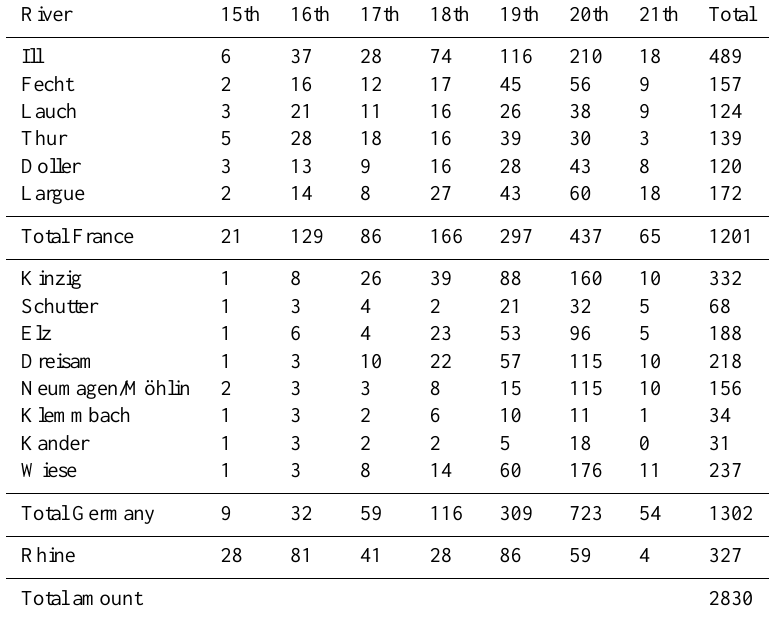
Table 2. Classification scheme for flood events